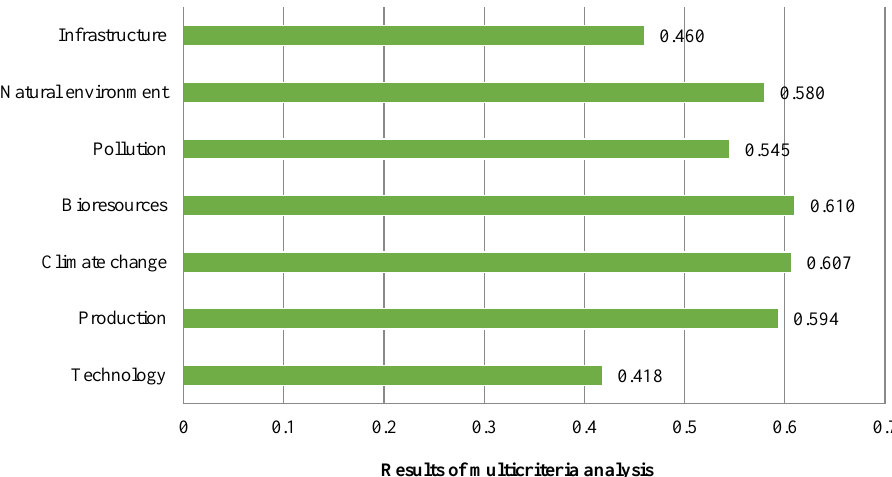
Fig. 2. Bioeconomy system influencing factors’ evaluation by using